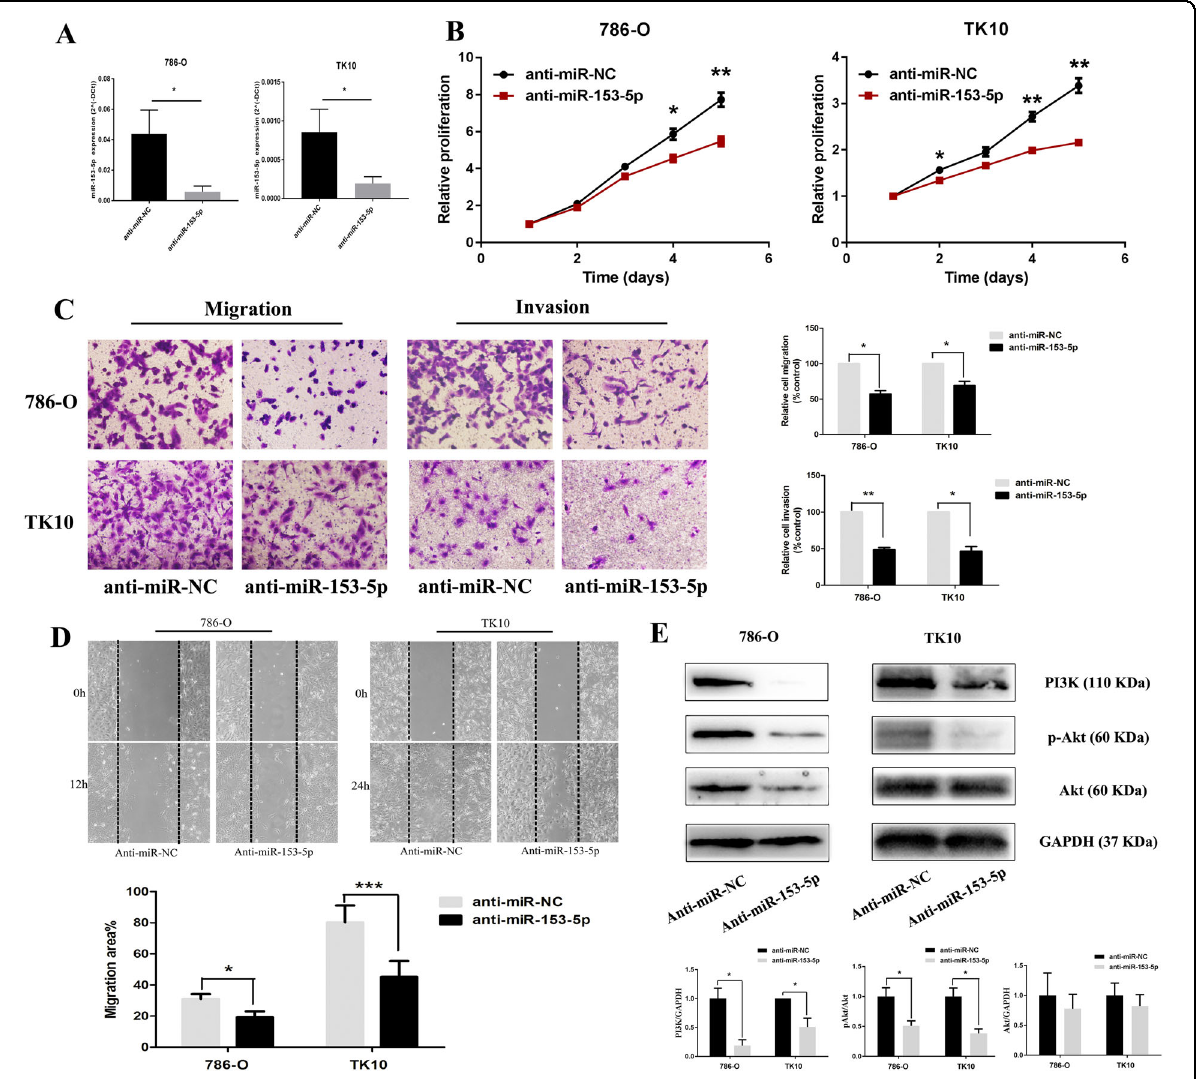
Fig. 3 MiR-153-5p knockdown decreased proliferation and metastasis of ccRCC via PI3K/Akt signaling. A The expression level of miR-153-5p in 786-O and TK10 after transfection with miR-153-5p inhibitor. B The proliferation rate of ccRCC after the miR-153-5p knockdown. C , D Effect of miR- 153-5p depletion on migration ( C , D ) and invasion ( C ). E Effect of miR-153-5p depletion on PI3K/Akt signaling. All experiments were conducted at least three independent times and all the values were presented as mean ± SEM. * P < 0.05, ** P < 0.01, *** P <